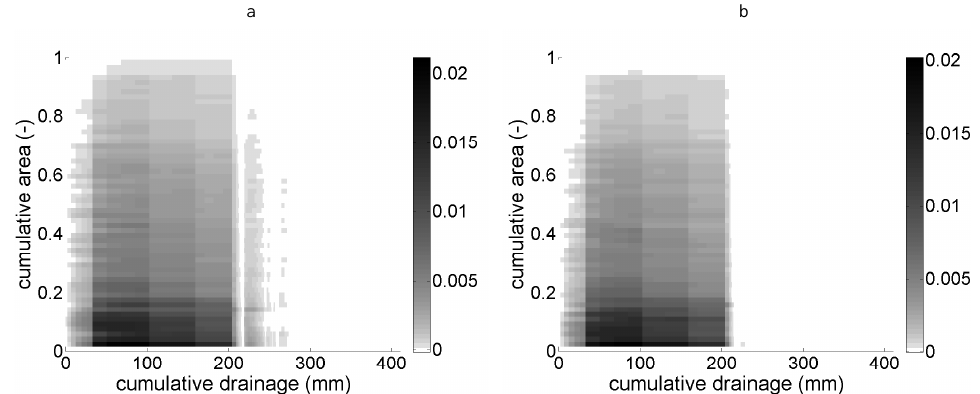
Fig. 9. Scaled solute flux density (d − 1 ) from simulations, at 0.5m depth, for the year 1997. (a) Tracer, (b) degradable solute (half-life time τ = 10d).